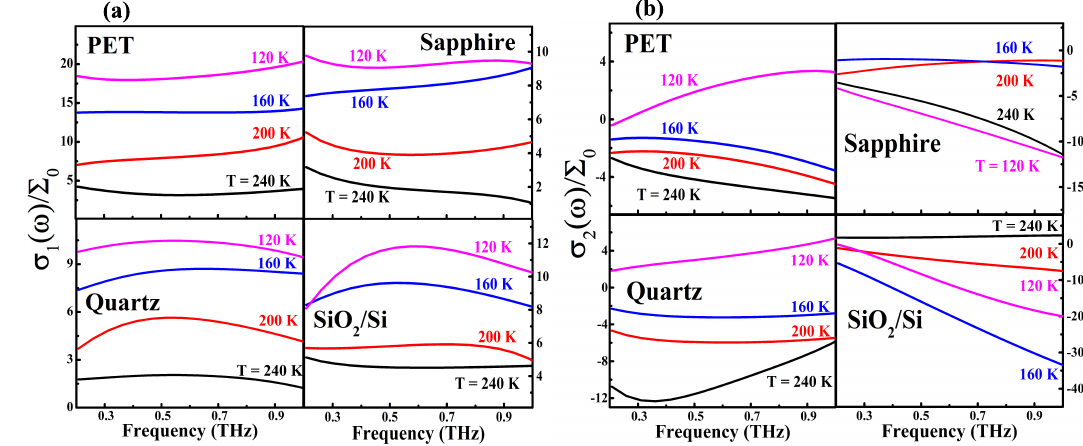
Figure 2. ( a ) Real σ 1 ( ω ) and ( b ) imaginary σ 2 ( ω ) parts of the optical conductivity as a function of radiation frequency f = ω /2 π at different temperatures for ML hBN on different substrates as indicated. Here, Σ 0 = e 2 /4¯ h = 6.07 × 10 − 5